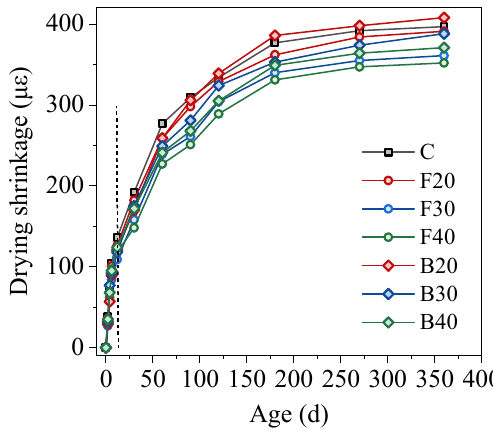
Figure 7. The drying shrinkages of the concrete containing FA and GGBS under an equal 28-day strength grade (dashed line: the shrinkage at 28 days).